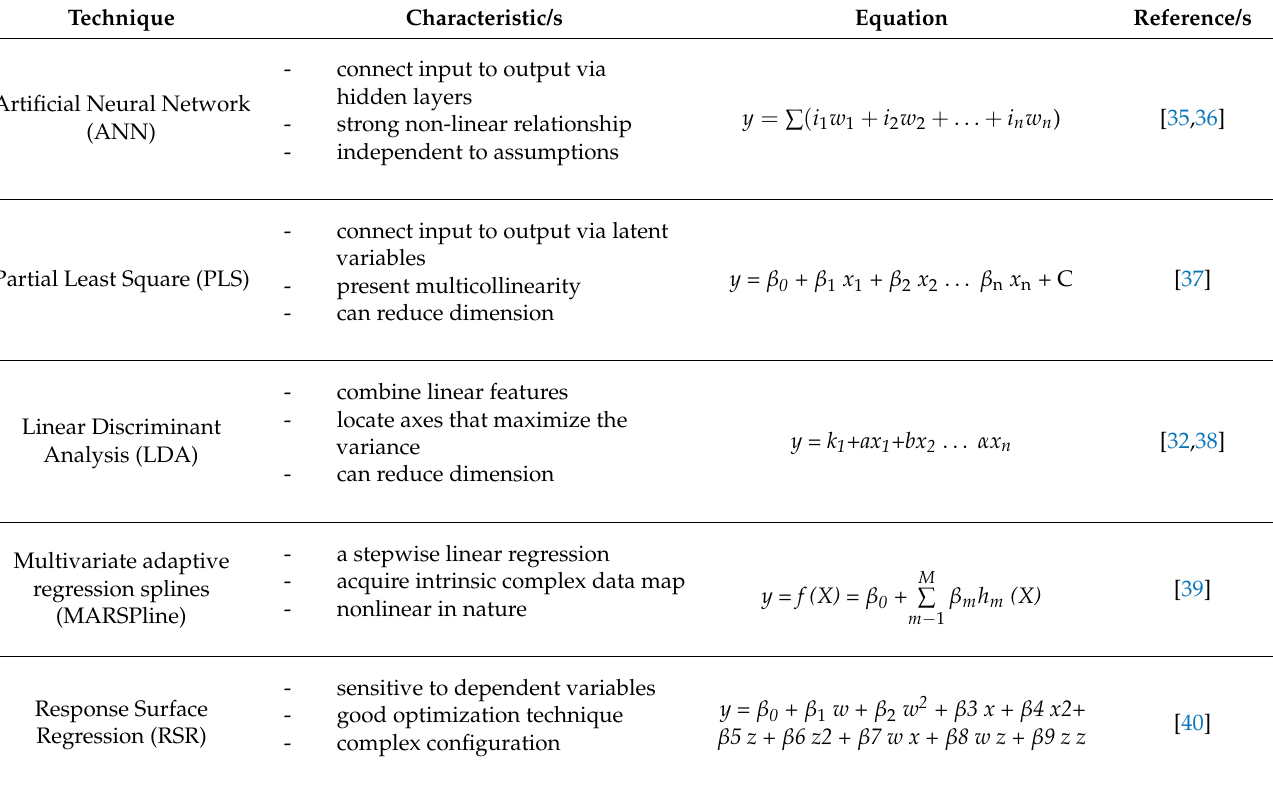
Table 2. Overview of the principal pattern-recognition techniques used in instrumental odour monitoring systems (IOMS). Technique Characteristic/s Equation Reference/s